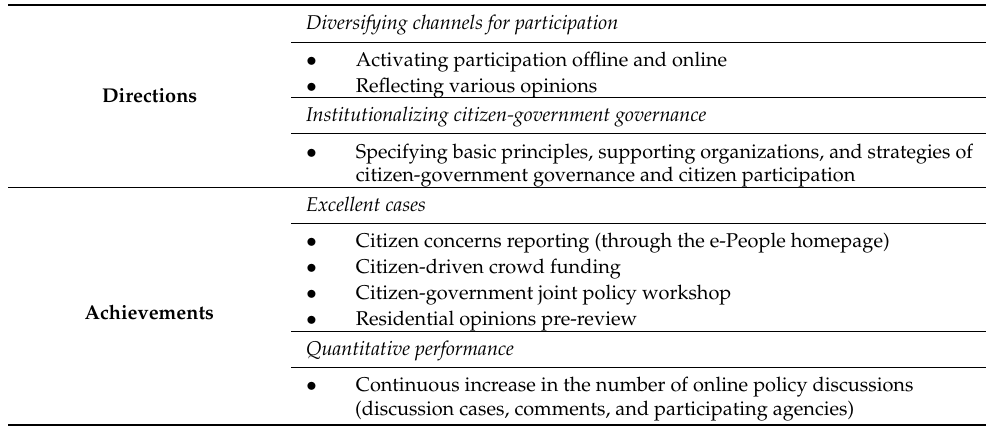
Table 2. Citizen-government governance through Government